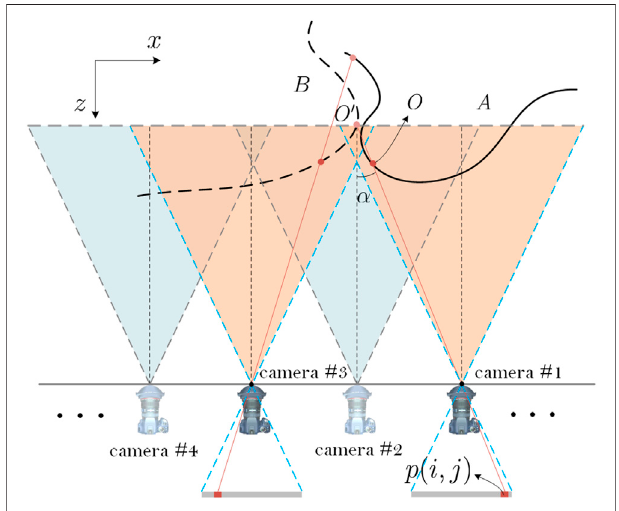
FIGURE 1 | Analysis of occlusion relationship between real and virtual scene.